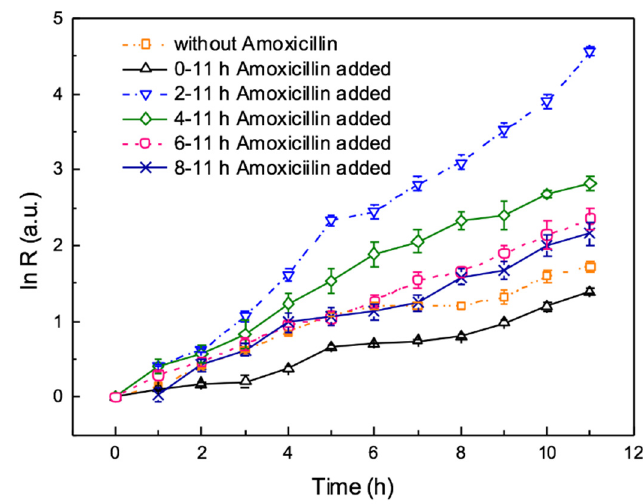
Figure 5. The effects of antibiotic on biofilm formation during the on-chip culture. 4 mg/L amoxicillin were added after 0, 1, 3, 5, 7 h incubation with continuous flow at the velocity of 0.5 μ L/min. Error bars are standard deviations.